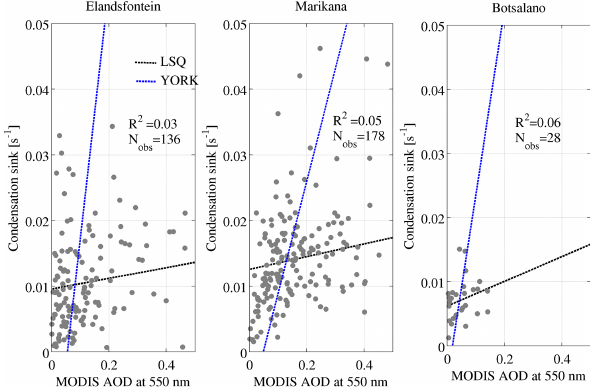
Figure 5. Comparison between MODIS AOD and in situ CS. The MODIS AOD values are spatial averages calculated from the obser- vations within 3km distance from the measurement station, whereas the CS values are 1h averages (13:00–14:00LT). The black lines represent the slope from least squares linear fitting (LSQ). The blue lines represent the fitting method where the uncertainties related to CS and AOD values have been taken into account (YORK; York et al., 2004). The uncertainty for CS was set to 10% and for AOD to 0 . 05 + 15% (Levy et al.,